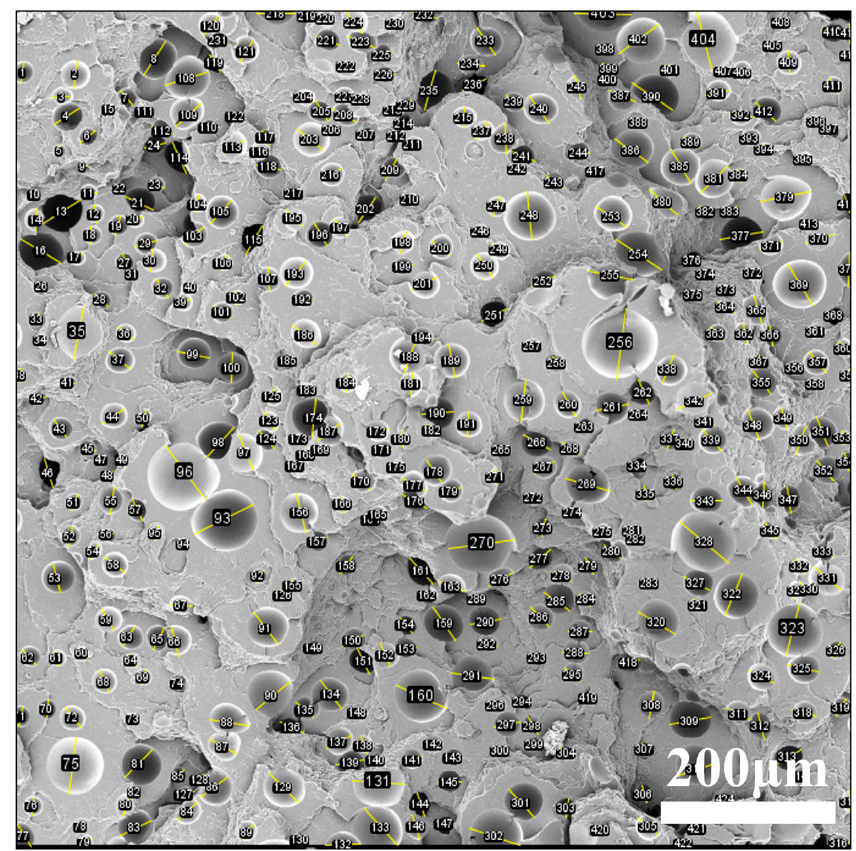
Figure 3. One of the polyurea tensile fracture holes and pore sizes analyzed by ImageJ.